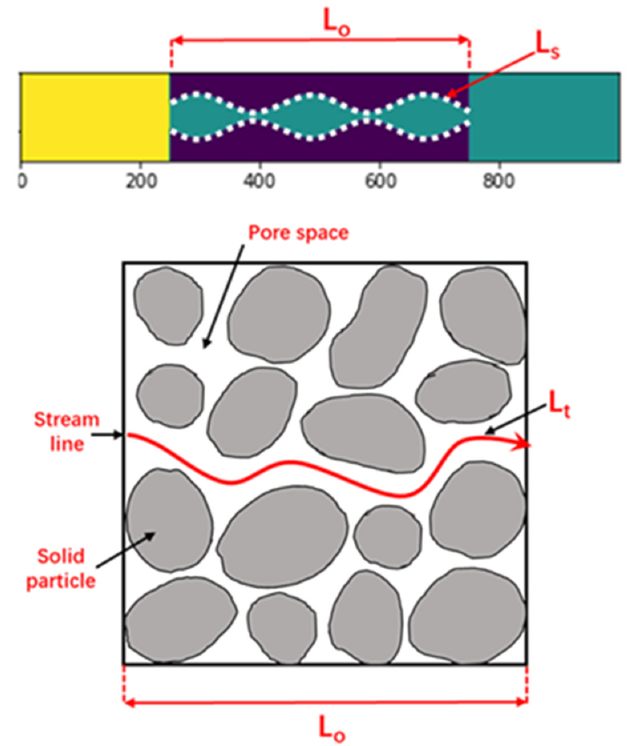
Figure 11. The pore-throat model and the porous media model.